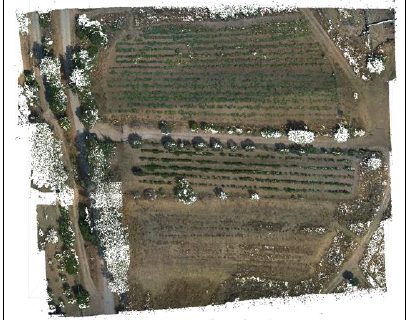
Figure 9. Dense Point cloud – 30 m